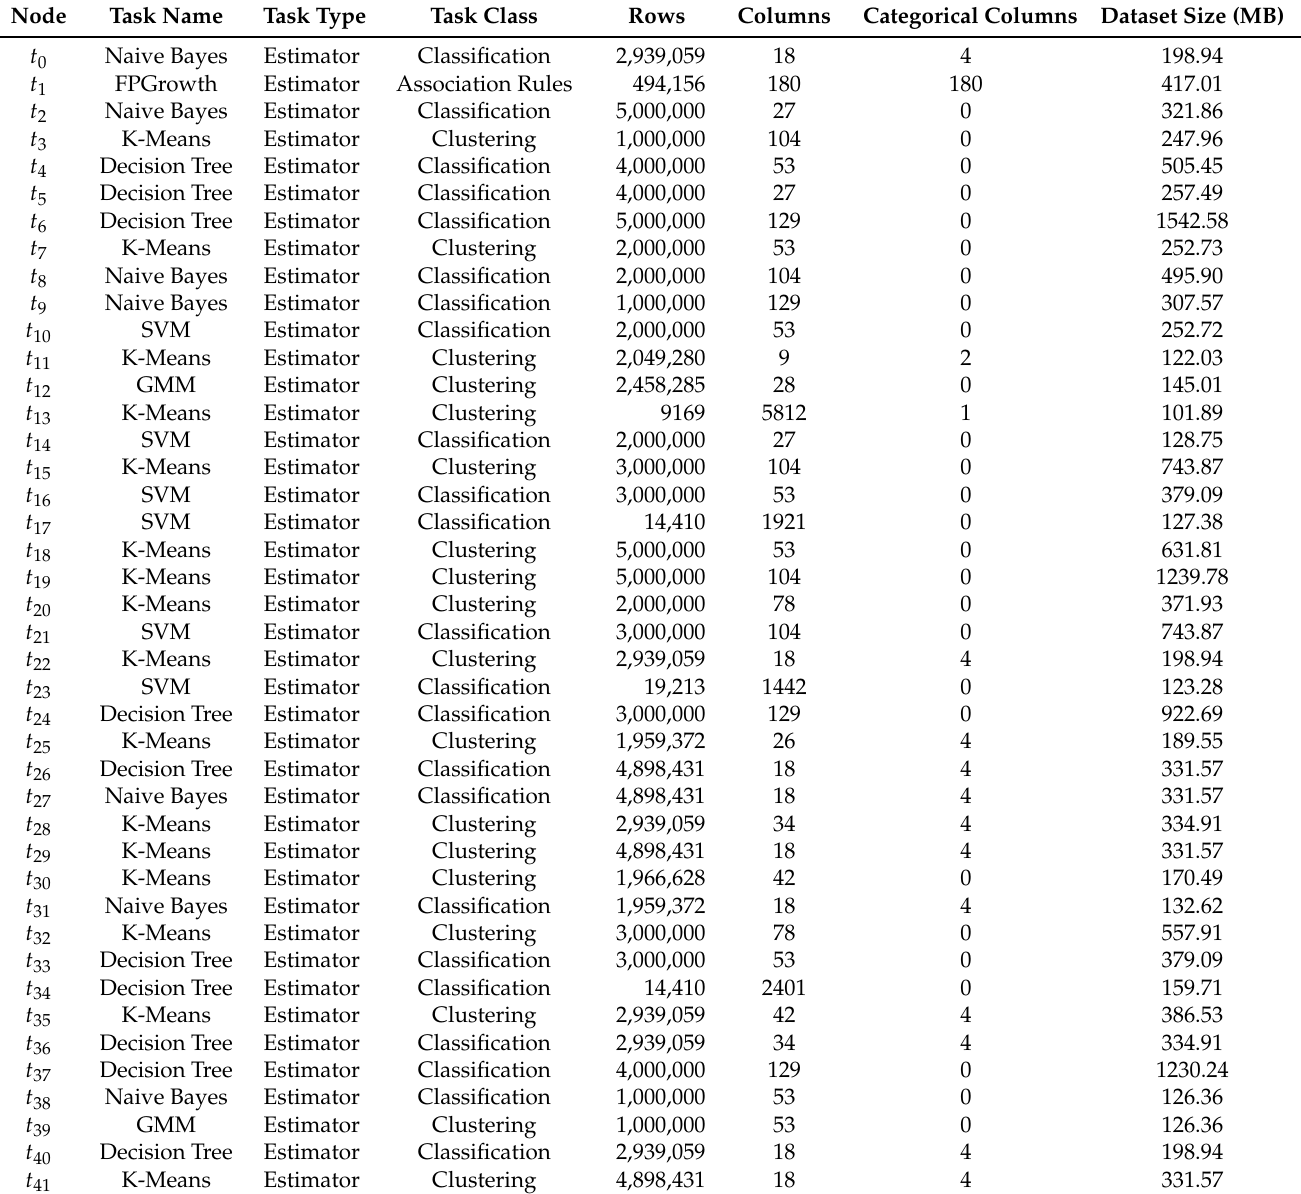
Table 6. Task and dataset descriptions (Workflow 1).